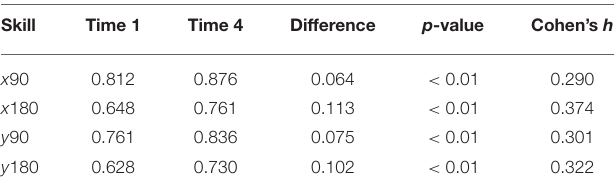
TABLE 8 | The Skill Mastery Rate (proportion of participants that master each skill). Skill